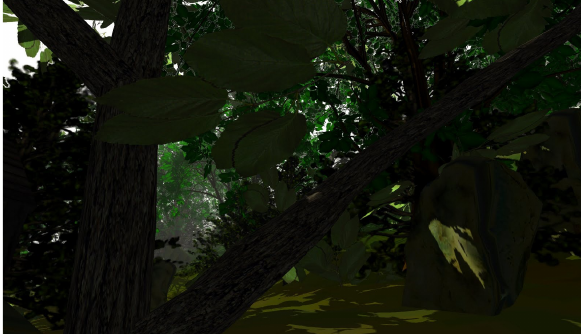
Figure 8. A vegetation cluster of a random generated world online with real time